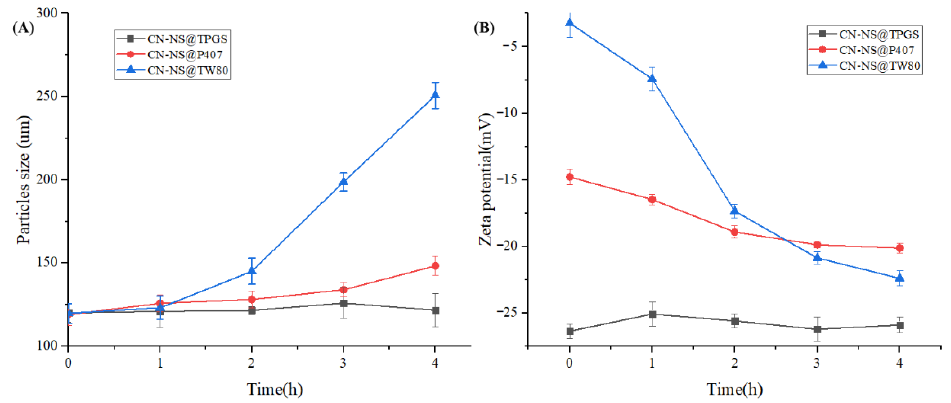
Figure 3. The changes in Zeta potential ( A ) and particle size ( B ) of the CN-NS incubated with mucin.